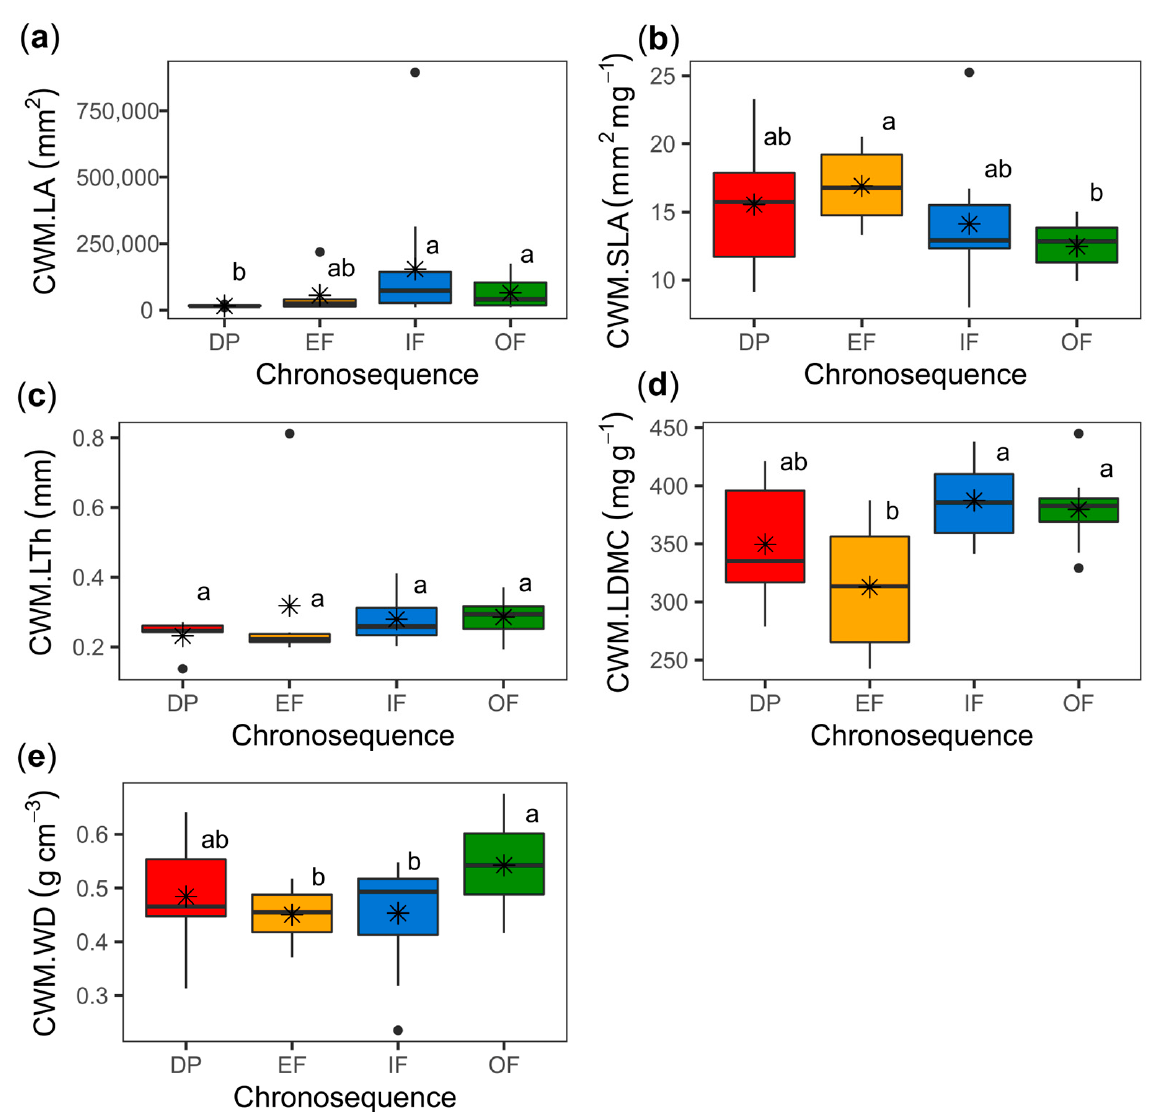
Figure 1. Community-weighted means (CWMs) of plant traits for the different successional categories (DP, degraded pasture; EF, early forest; IF, intermediate forest; OF, old-growth forest or mature forest); ( a ) LA, leaf area; ( b ) SLA, specific leaf area; ( c ) LTh, leaf thickness; ( d ) LDMC, leaf dry matter content; ( e ) WD, wood density. Asterisk (*) represent mean values. The upper and lower whiskers represent the maximum and minimum values established at the third (+1.5 IQR) and first quartile position ( − 1.5 IQR), respectively. For each trait, values between successional categories followed by the same letter do not differ statistically according to Fisher’s LSD post hoc test ( p < 0.05).